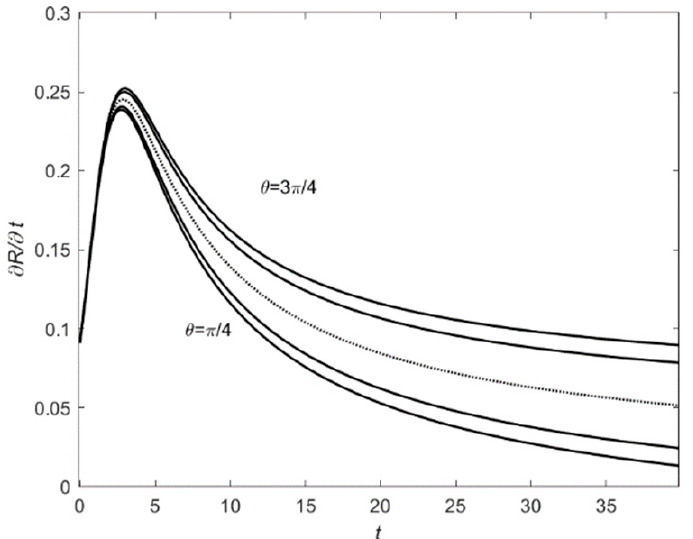
, , 5 /12 π 1.2 A B = = , where 0 0